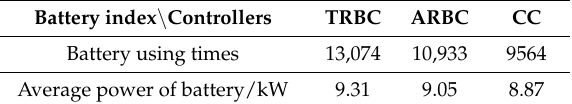
Table 9. Results of battery in three controllers.